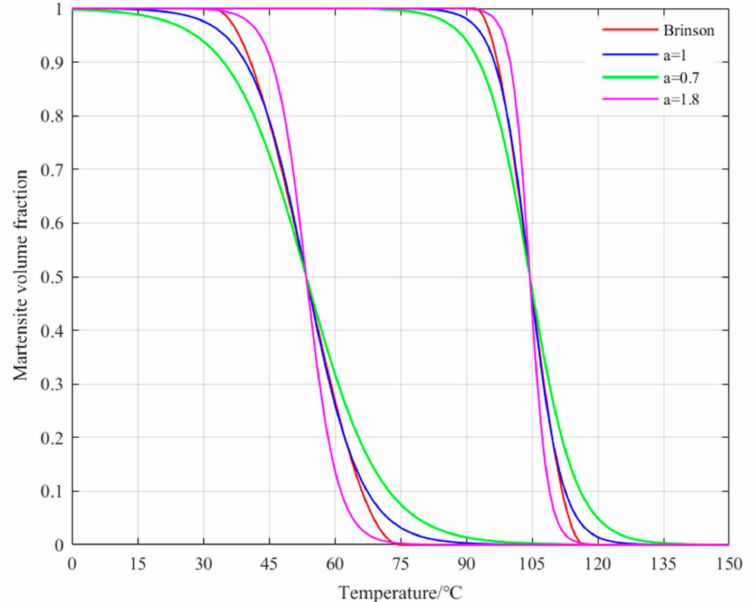
Figure 2. Relationship between the martensite volume fraction and the temperature for different transformation rate